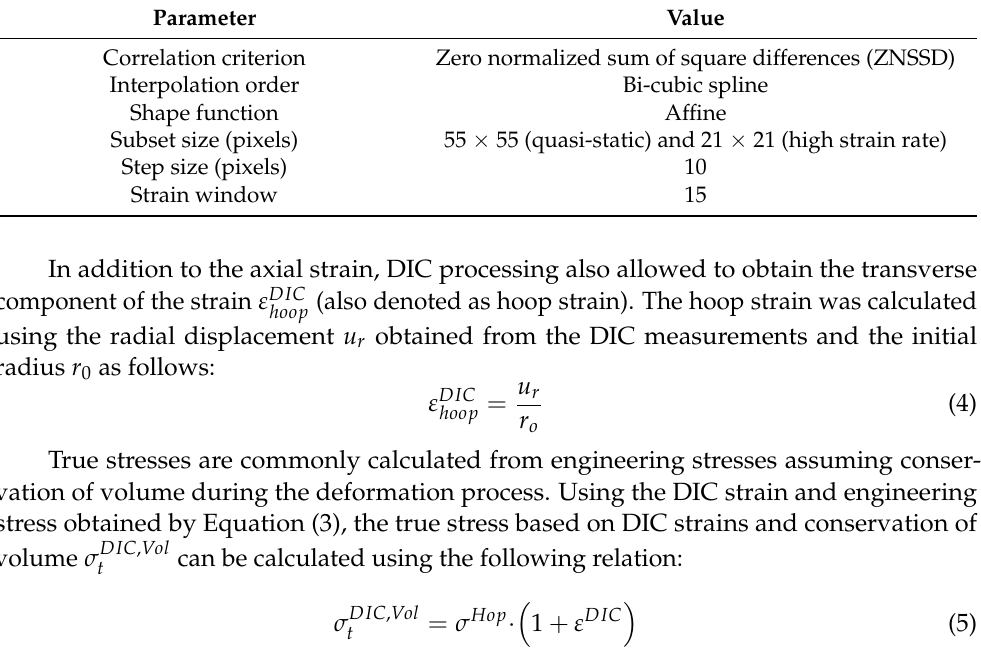
Table 1. Processing parameters for DIC. Parameter Value Correlation criterion Zero normalized sum of square differences (ZNSSD) Interpolation order Bi-cubic spline Shape function Affine Subset size (pixels) 55 × 55 (quasi-static) and 21 × 21 (high strain rate) Step size (pixels) 10 Strain window